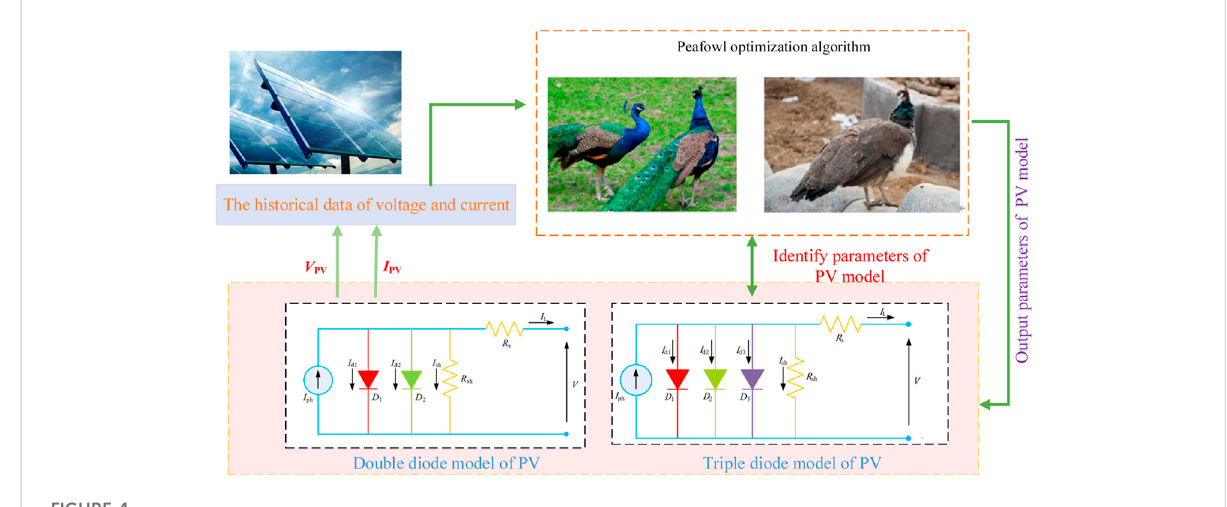
FIGURE 4 Application process of POA for parameter identi fi cation of PV cell.